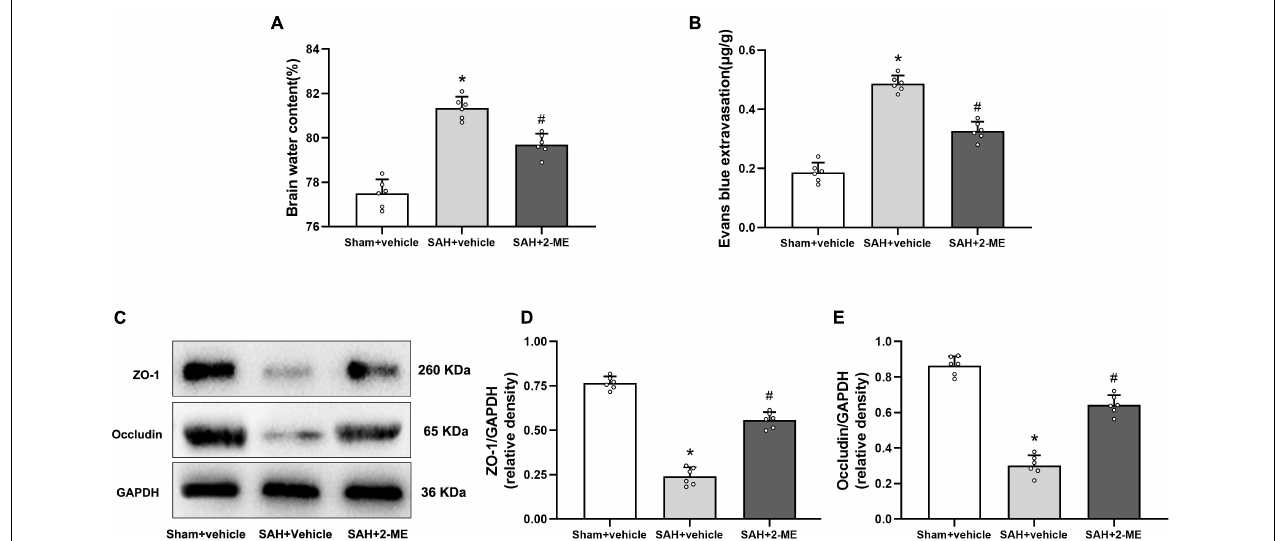
FIGURE 5 | Effect of 2-ME on brain edema, BBB permeability, and the expression of ZO-1 and occludin. (A) Brain water content in different groups ( n = 6 per group). (B) Evans blue extravasation in different groups ( n = 6 per group). (C) Representative result of western blotting of ZO-1 and occludin of the ipsilateral basal cortex in different groups. Western blotting assay for the expression of ZO-1 (D) and occludin (E) of the ipsilateral basal cortex in different groups at 24 h after SAH induction. Relative optical densities (O.D.) of ZO-1 and occludin were normalized to that of GAPDH. Data are shown as mean ± SD ( n = 6 per group). * P < 0.05 vs. the Sham + vehicle group; # P < 0.05 vs. the SAH + vehicle group.